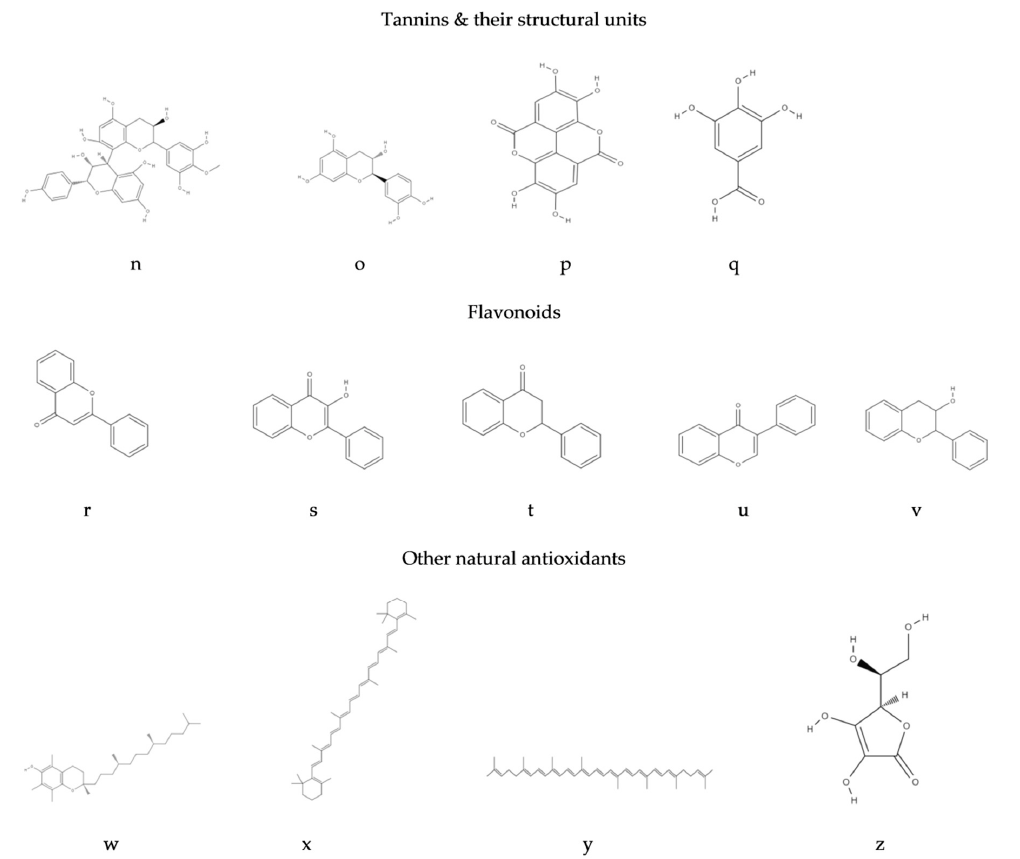
Figure 3. Basic chemical structures of selected phenolic antioxidants. Phenols: ( a ) phenol, ( b ) benzoquinone, ( c ) phenolic acid, ( d ) acetophenone, ( e ) phenylacetic acid, ( f ) hydroxycinnamic acid, ( g ) 2-phenylpropene, ( h ) coumarin, ( i ) chromone, ( j ) xanthone, ( k ) naphthoquinone, ( l ) lignans, ( m ) stilbene. Tannins: ( n ) proanthocyanidins, ( o ) catechin, ( p ) ellagic acid, ( q ) gallic acid. Flavonoids: ( r ) flavone, ( s ) flavanol, ( t ) flavanone, ( u ) isoflavone, ( v ) flavan-3-ol. Other natural antioxidants: ( w ) α -tocopherol, ( x ) β -carotene, ( y ) lycopene, ( z ) vitamin C.